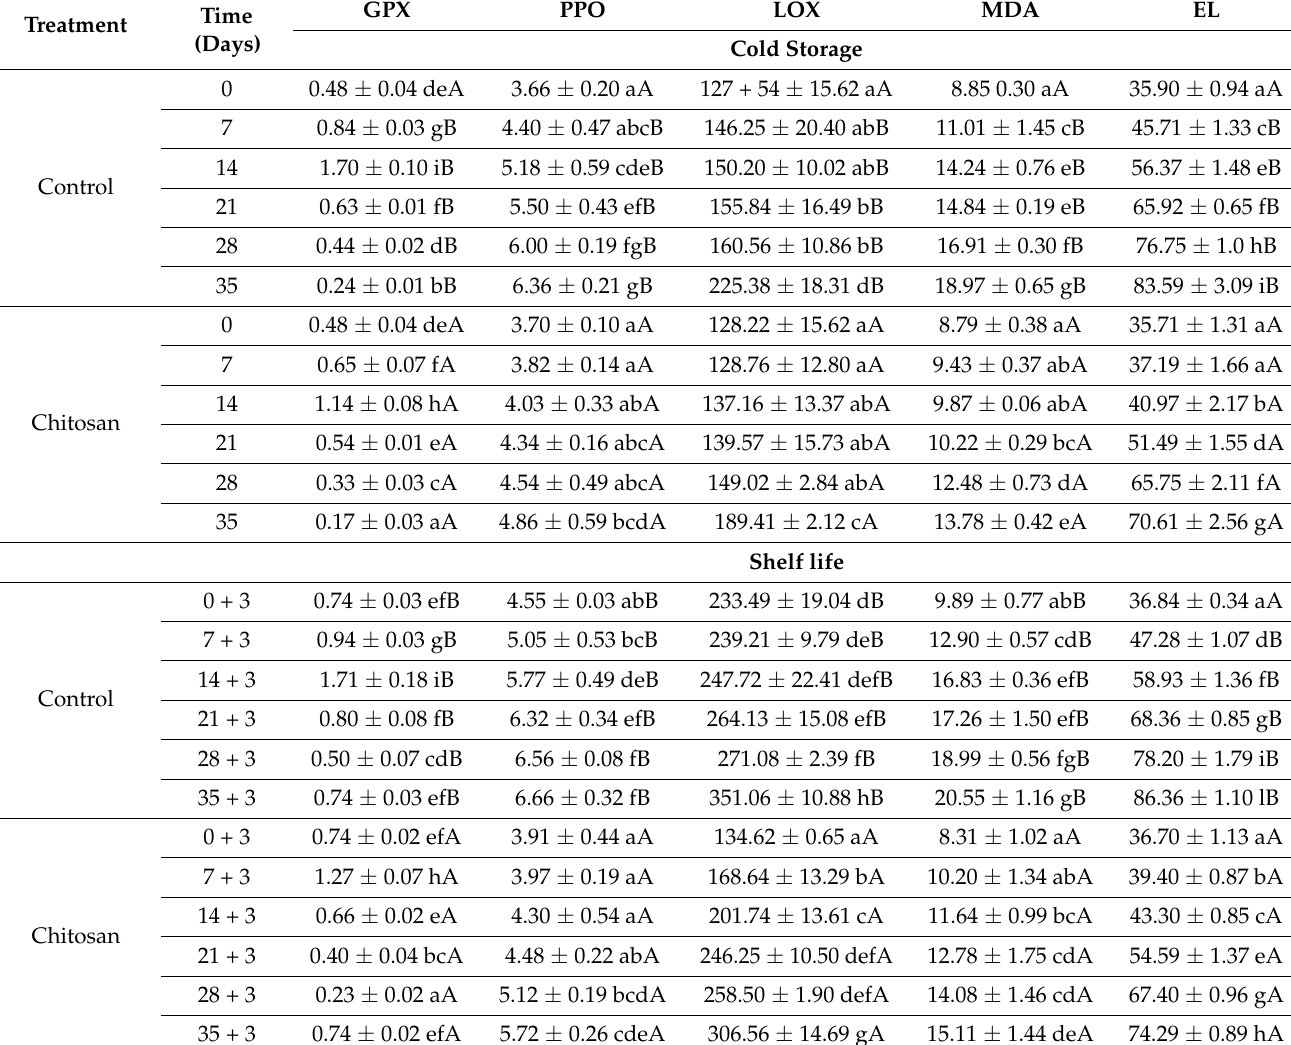
Table 3. Activity of guaiacol peroxidase (GPX; µ mol guaiacol per mg protein), polyphenol oxidase (PPO; mmol per mg protein) and lipoxygenase (LOX; mmol per mg protein), malondialdehyde content (MDA; nmol per g FW) and electrolyte leakage (EL;%) at harvest (0) and after 7, 14, 21, 28 and 35 days of cold storage followed by 3 days of shelf life for chitosan-coated (Chitosan) and uncoated fruit